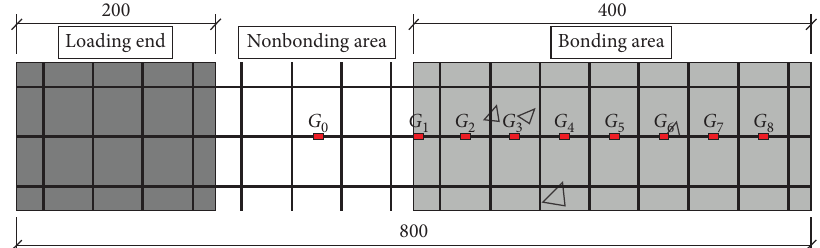
Figure 6: Arrangement of strain gauges on the BFRP grid.